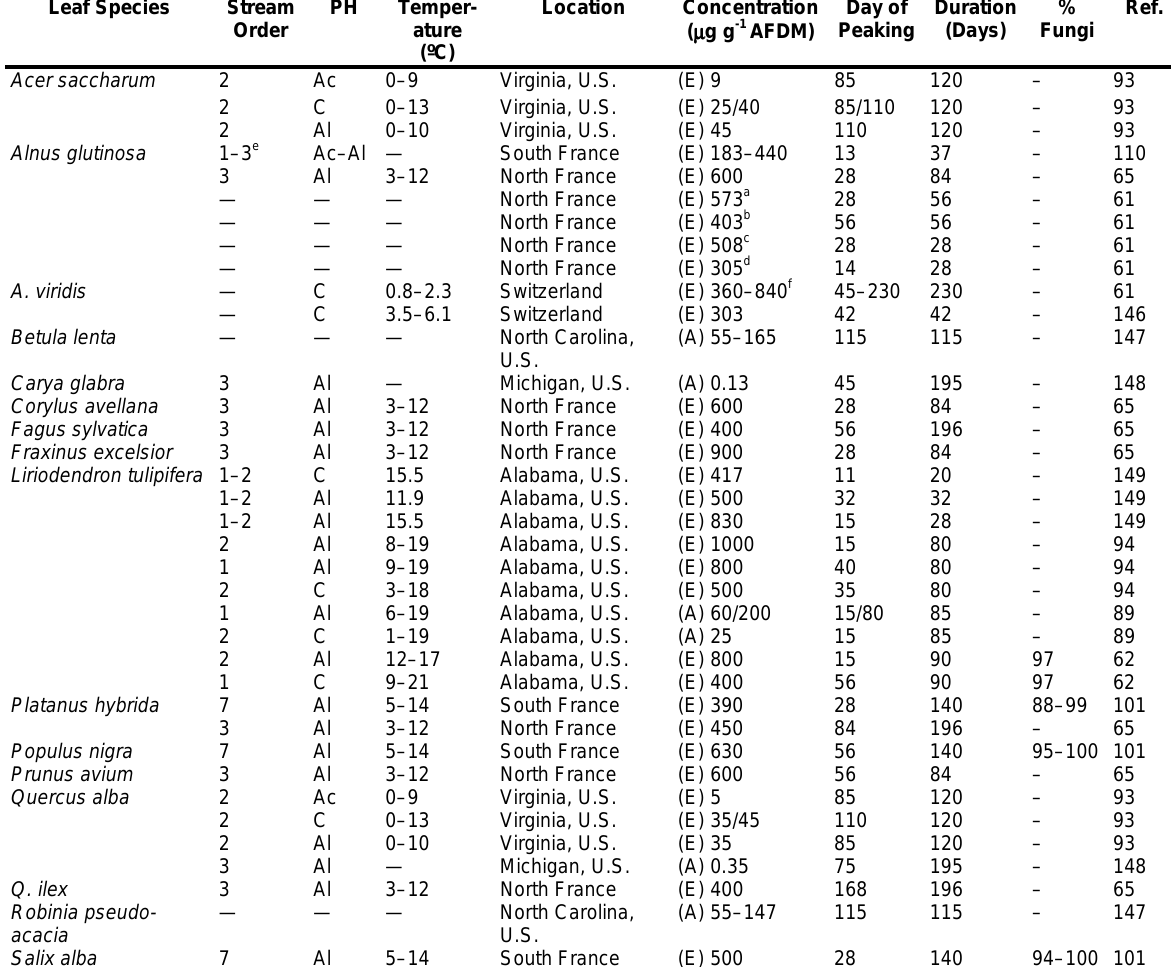
Maximum Ergosterol (E) or ATP (A) Concentrations Associated with Decomposing Leaf Litter in Leaf Species